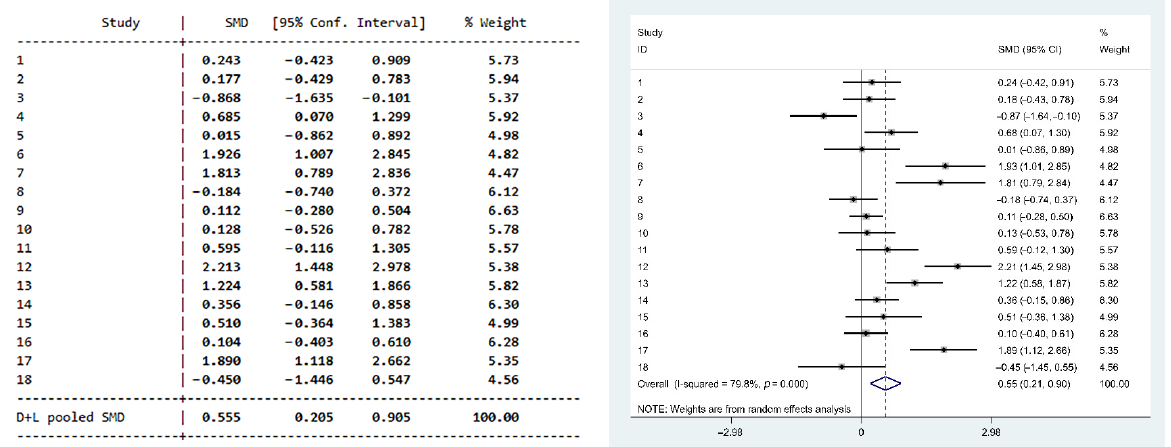
Figure 2. Forest plot of the overall mean effect size, as well as the effect size for each study included in the analysis.